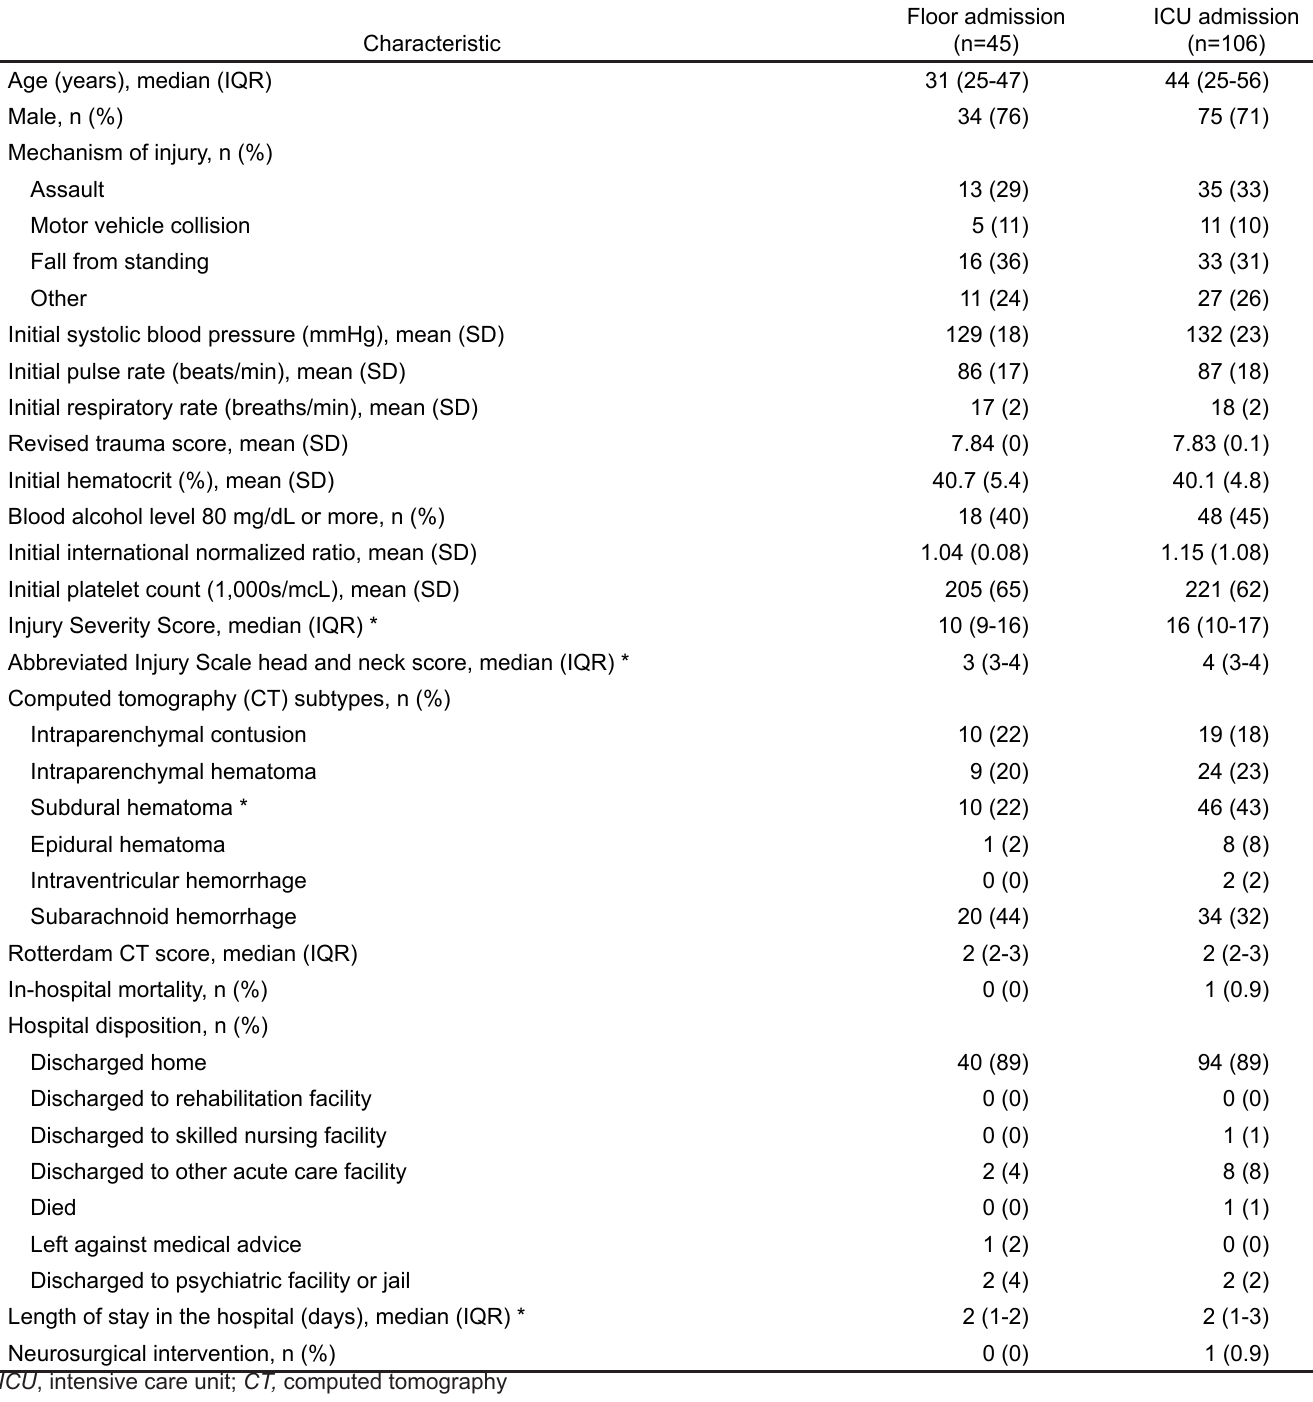
Table 1. Patient characteristics by hospital admission